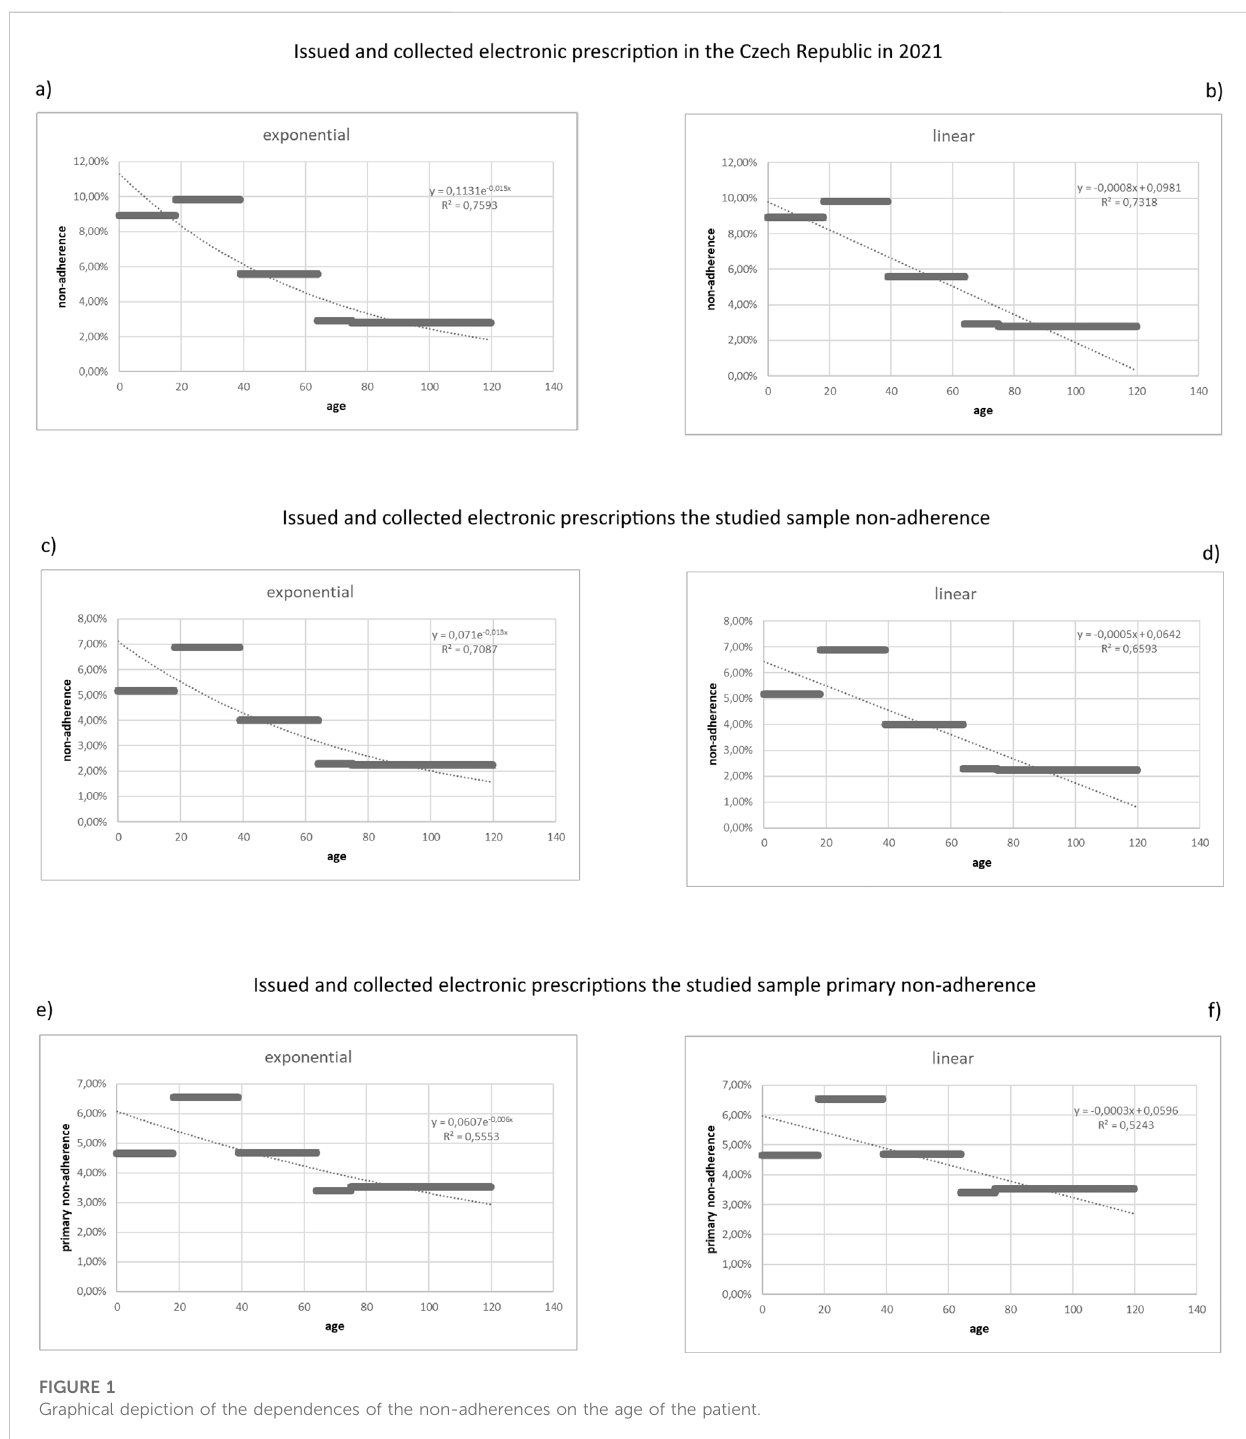
FIGURE 1 Graphical depiction of the dependences of the non-adherences on the age of the